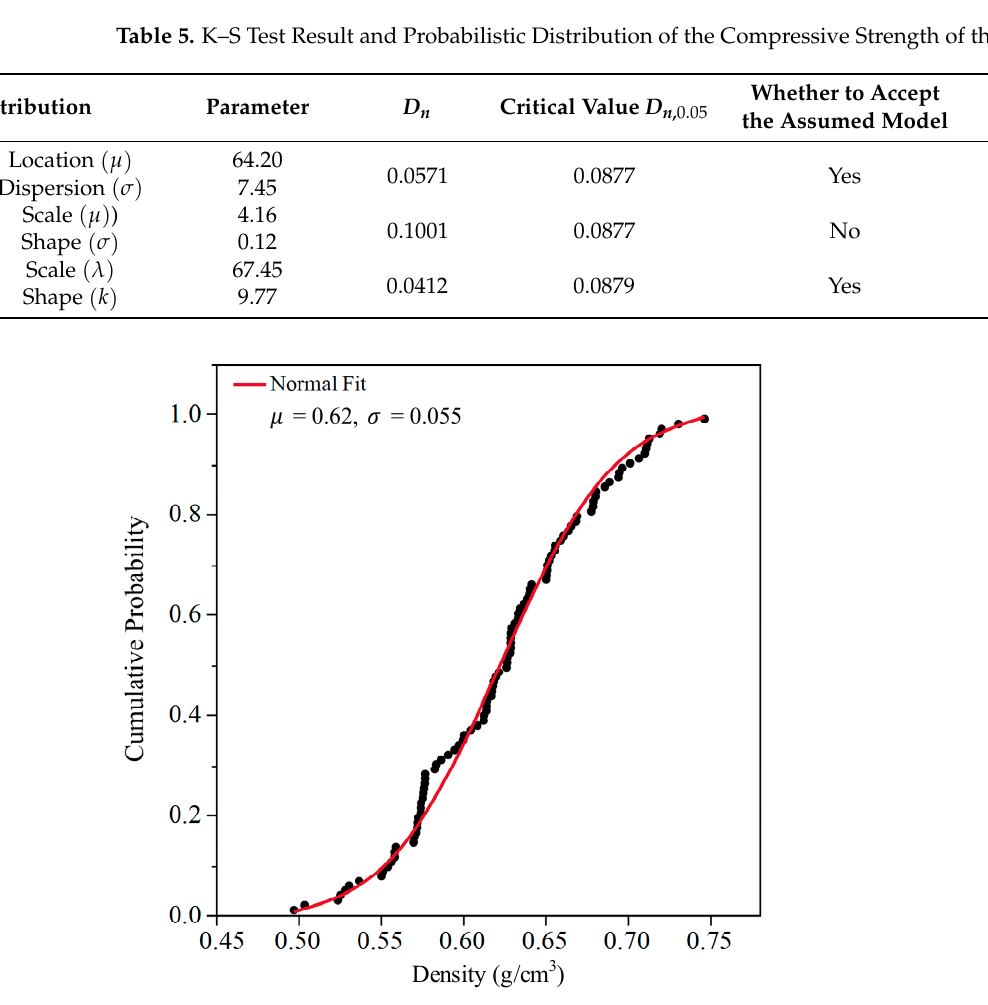
Figure 5. Cumulative probability of density for lamina and fit by the normal distribution.